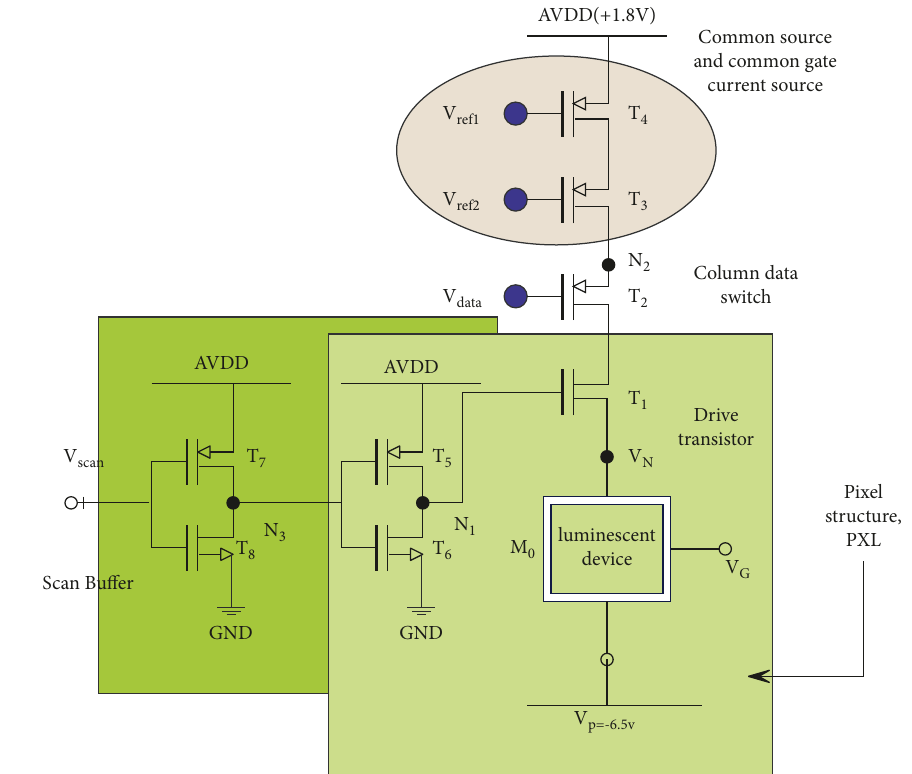
Figure 1: Pixel drive circuit.